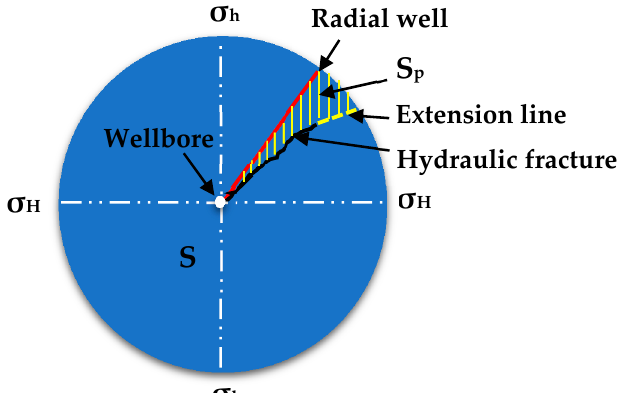
Figure 6. Schematic diagram of the guiding factor “ G f ”.